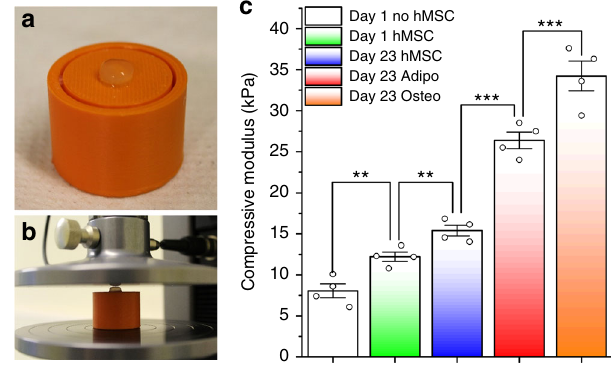
Fig. 6 Compression testing of 3D hMSC fi brin hydrogel constructs. Images of a 3D hMSC fi brin hydrogel construct (Dia. = 8.0 mm; depth ∼ 4.2 mm; ≈ 4 × 10 6 cells) before ( a ) and during ( b ) uncon fi ned compression testing. c Compressive modulus ( n = 4) of fi brin gels containing [sc_thrombin] [ox890] coated hMSCs cultured for 23 days in undifferentiated, adipogenic or osteogenic media, [sc_thrombin][ox890] coated hMSCs cultured for 1 day in undifferentiated media and native thrombin (200 nM) catalysed (no hMSCs) after 1 day. Data reported as the means ± s.e.m. Tukey ’ s test; ** p ≤